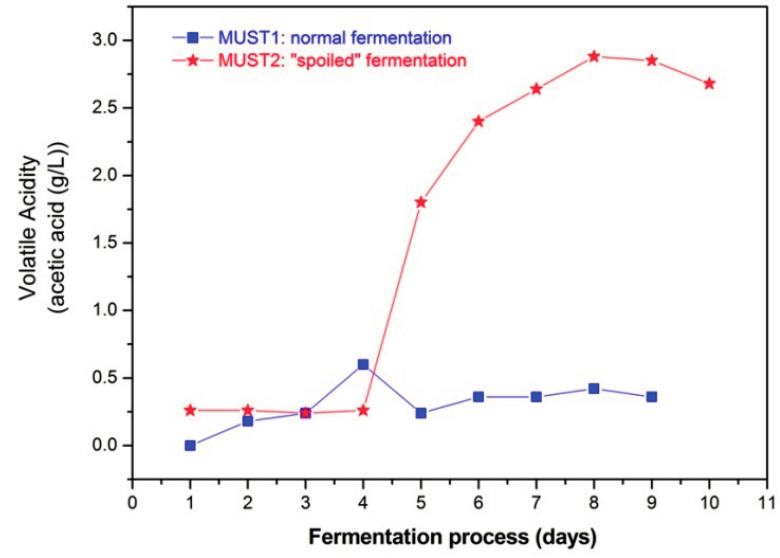
Figure 4. Volatile acidity propagation during the two fermentation processes. The results obtained by standard chemical analysis with steam distillation and titrimetry.